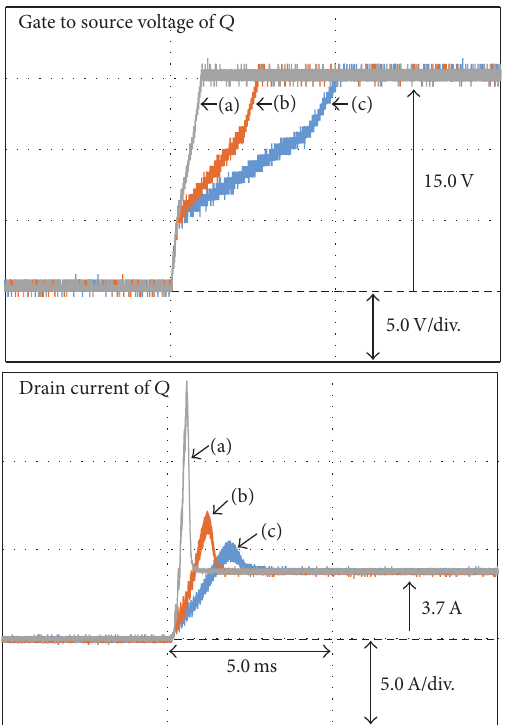
Figure 6: Active gate controlled gate to source voltage and drain current of protection switch.